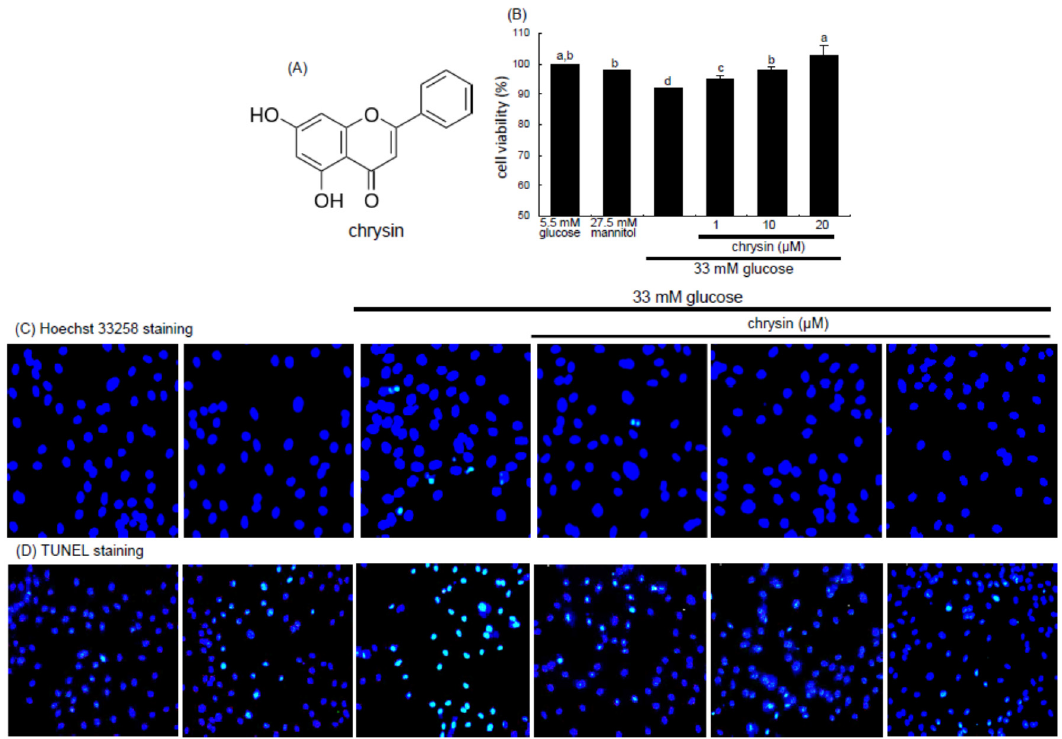
Figure 1. Chemical structure of chrysin ( A ); inhibitory effects of chrysin on viability ( B ); nuclear condensation ( C ); and DNA fragmentation ( D ) in and glucose toxicity of retinal endothelial cells. human retinal microvascular endothelial cells (HRMVEC) were incubated with 33 mM glucose in the absence and presence of 1–20 μ M chrysin up to five days. Cells were also incubated with 5.5 mM glucose and 27.5 mM mannitol as osmotic controls. After HRMVEC were cultured in media for two days, cell viability was measured by using MTT assay ( n = 3, 100% viability with 5.5 mM glucose). Means not sharing a common letter differ, p < 0.05. Nuclear condensation was examined with Hoechst 33258 in HRMVEC ( C ) and the DNA fragmentation measured with TUNEL assay and nuclear staining was done with 4 ′ ,6 ‐ diamidino ‐ 2 ‐ phenylindole (DAPI) ( D ). Representative microphotographs were obtained by fluorescent microscopy with fluorescein green filter. Magnification: 200×. Fluorescence intensity was quantified by using an Axiomager (Zeiss, Oberkochen, Germany). microscope system. Respective values not sharing a letter are different at p < 0.05.